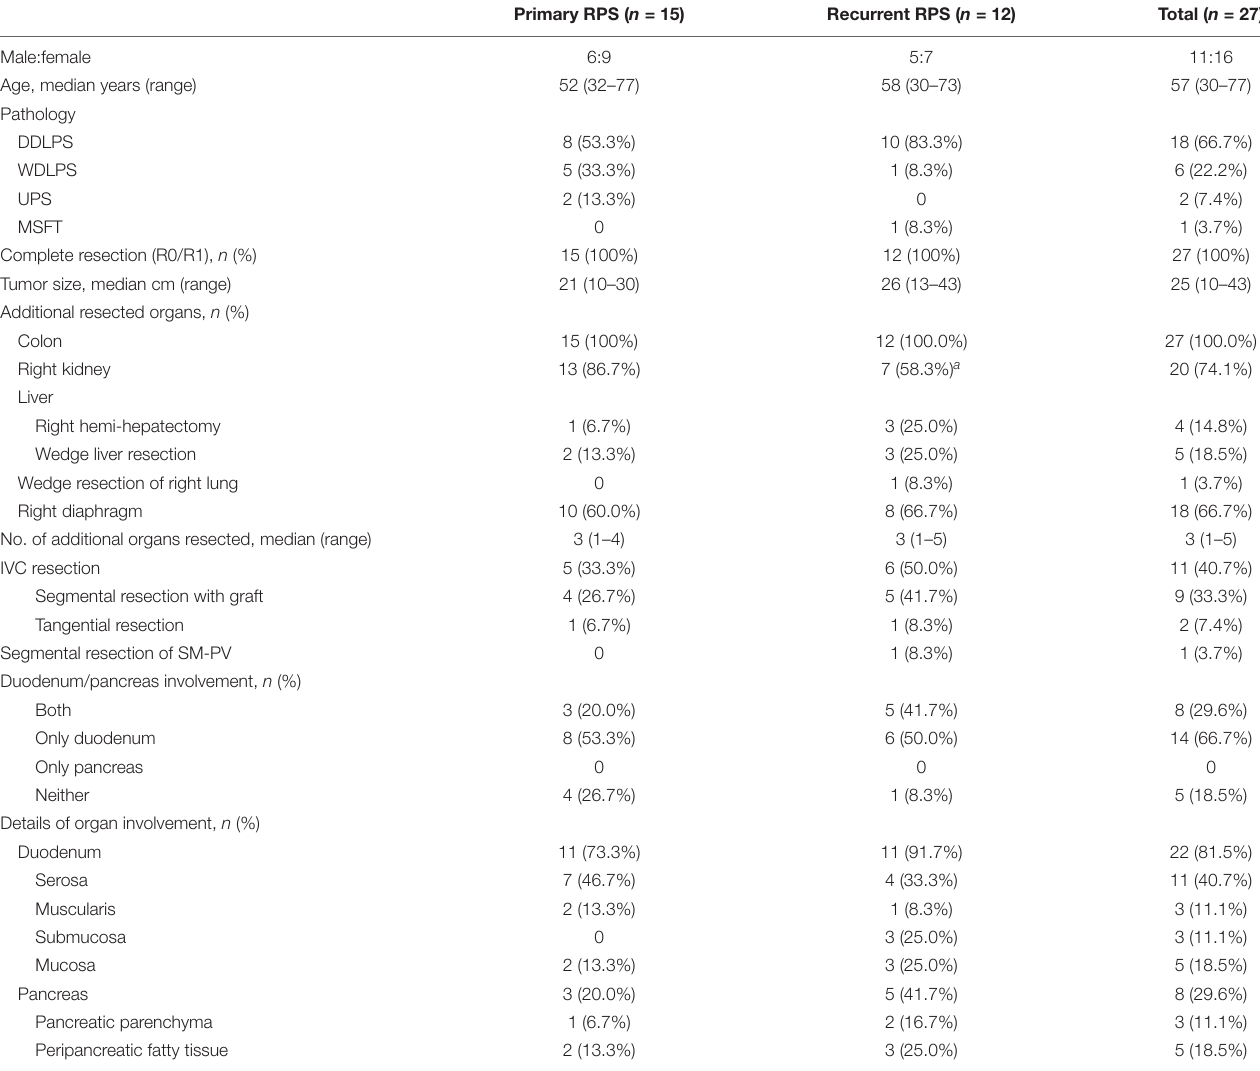
TABLE 1 | Clinicopathologic characteristics of patients underwent PD during RPS resection. Primary RPS ( n = 15) Recurrent RPS ( n =